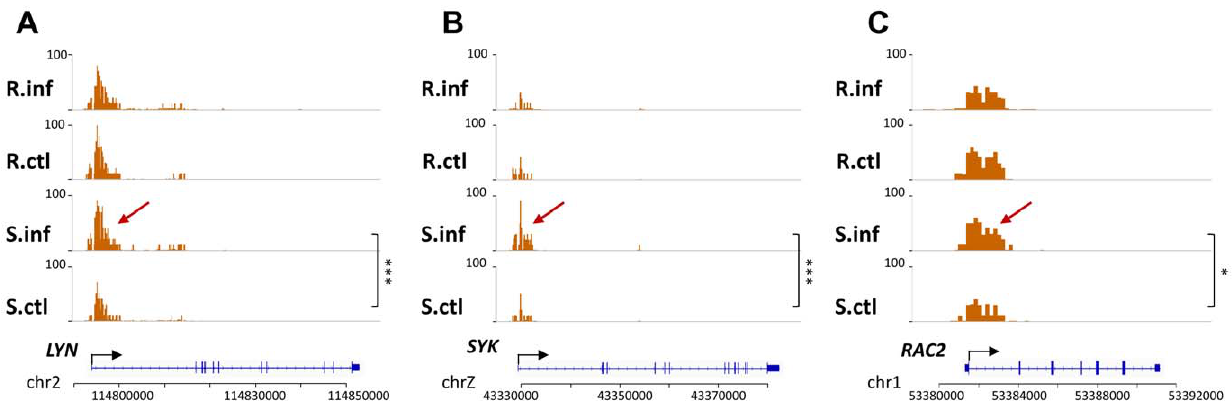
Figure 4. Differentially marked regions detected by WaveSeq suggest increased B cell activation in susceptible chickens. Several genes involved in the B cell activation such as LYN (a), SYK (b) and RAC2 (c) show increased levels of H3K4me3 in infected birds from the S group as shown by the arrowheads. In contrast, there are no significant changes in the R group. This suggests the presence of increased numbers of activated B cells in susceptible birds that may lead to increased viral loads in latter stages of MD. ***=p , 0.001; *=p , 0.05. S.inf=infected S group, S.ctl=control S group, R.inf=infected R group, R.ctl=control R group.